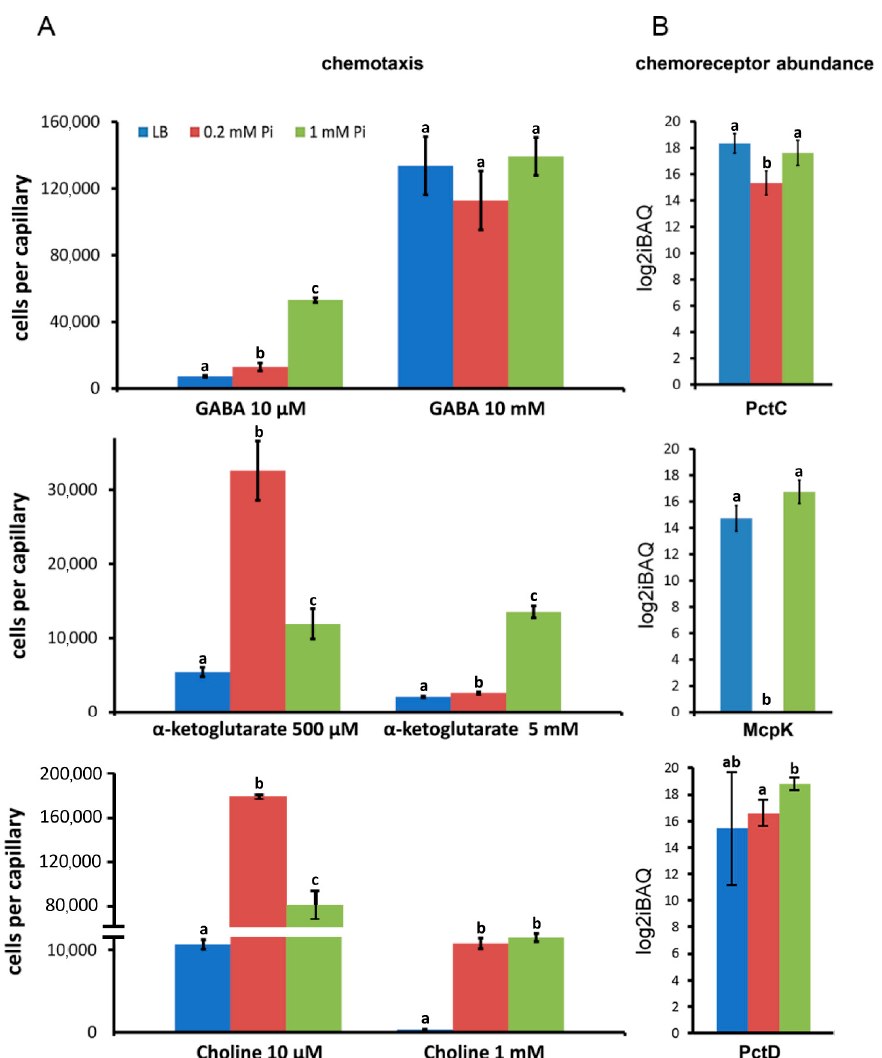
Figure 4. Relationship between the magnitude of chemotaxis and the cellular abundance of the corresponding chemoreceptors. ( A ) Quantitative capillary chemotaxis assays of P. aeruginosa PAO1 to GABA, α -ketoglutarate, and choline. Cells were grown the same way as for the proteomics analyses [49]. Responses have been corrected with the number of cells that swam in buffer-containing capillaries, namely 7350 ± 3850 (GABA), 6400 ± 2667 ( α -ketoglutarate), and 7500 ± 3500 (choline). ( B ) Cellular protein amounts of the PctC, McpK, and PctD chemoreceptors in P. aeruginosa PAO1 grown under the conditions used for the chemotaxis assays. Differences between bars with the same letter are not statistically significant ( p -value < 0.05; by Student’s t -test).